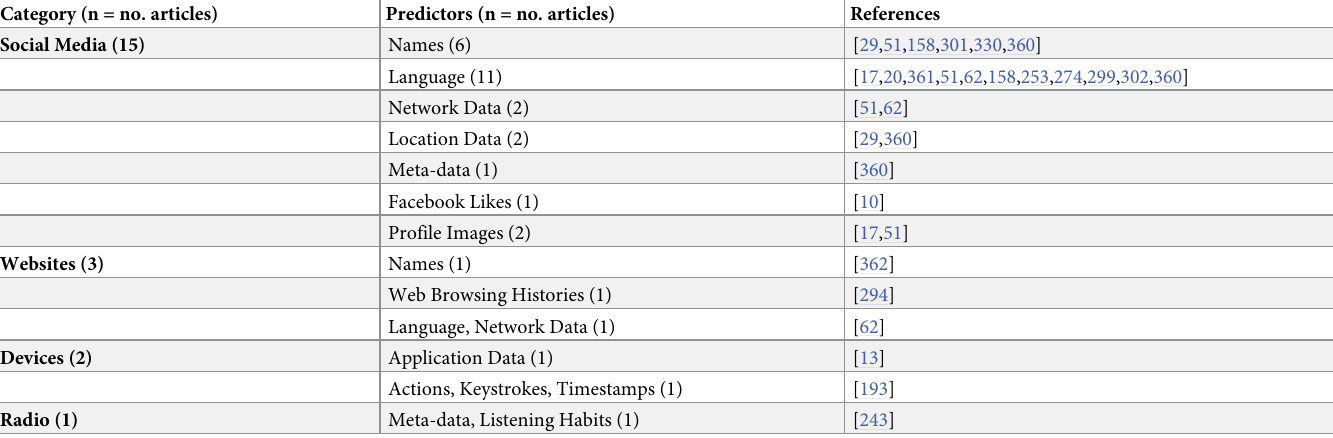
Table 14. Number of articles predicting ethnicity or race, with associated predictors and references. Category (n = no. articles)